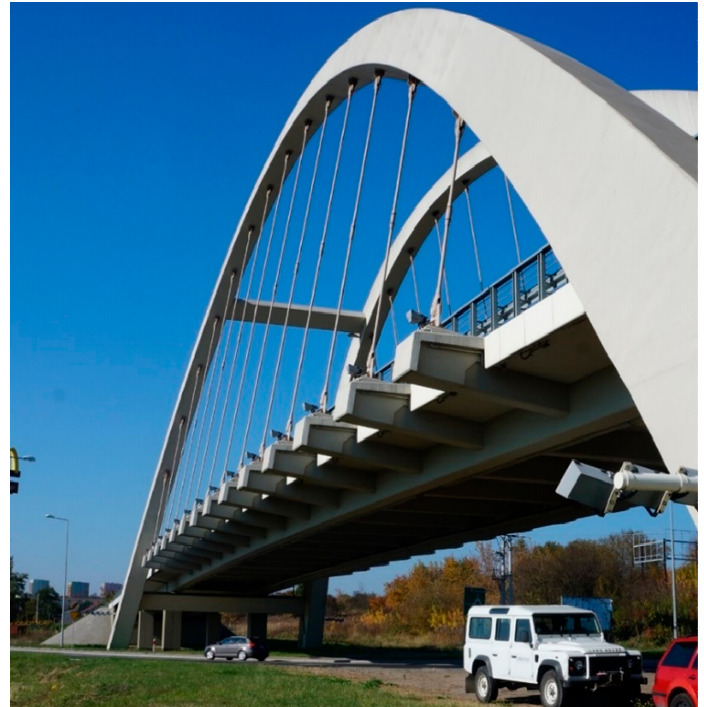
Figure 7. The road viaduct in Chrzanow, Southern Poland.